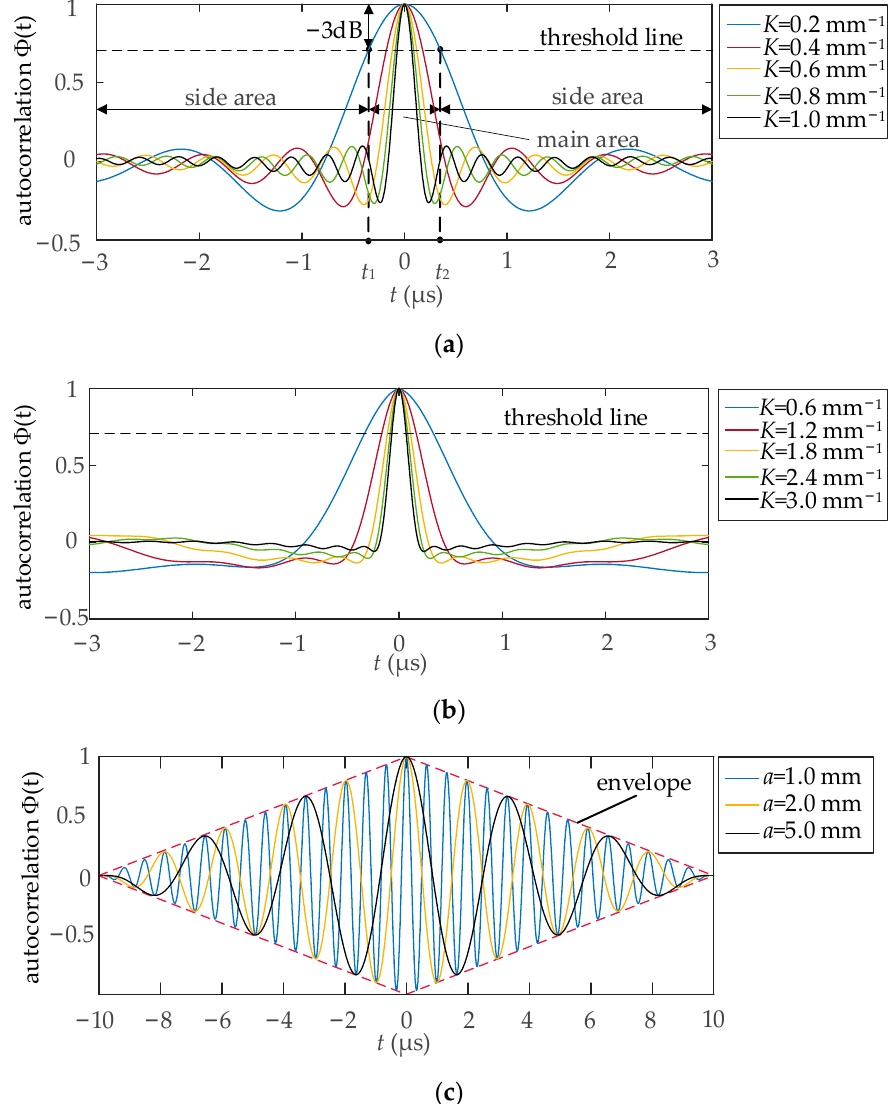
Figure 6. Autocorrelation functions Φ ( t ) with different structures and parameters: ( a ) LWM coils; ( b ) NLWM coils; ( c ) ES coils.